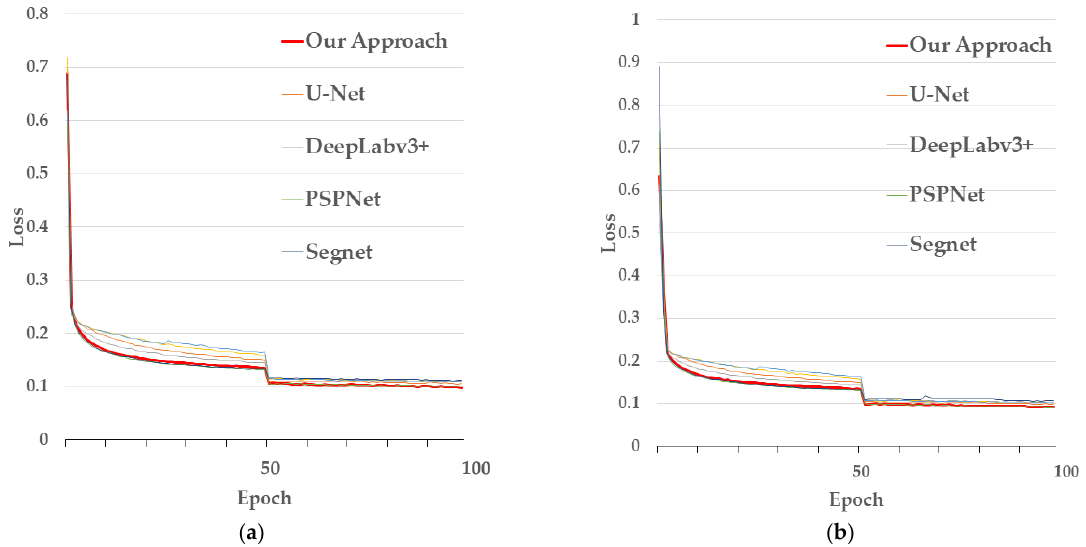
Figure 13. LPASS-Net training evolution of the loss function on ( a ) the BDCI 2017 dataset and ( b ) the ISPRS Potsdam dataset, respectively; the red line represents train loss, and the green line represents validation loss.